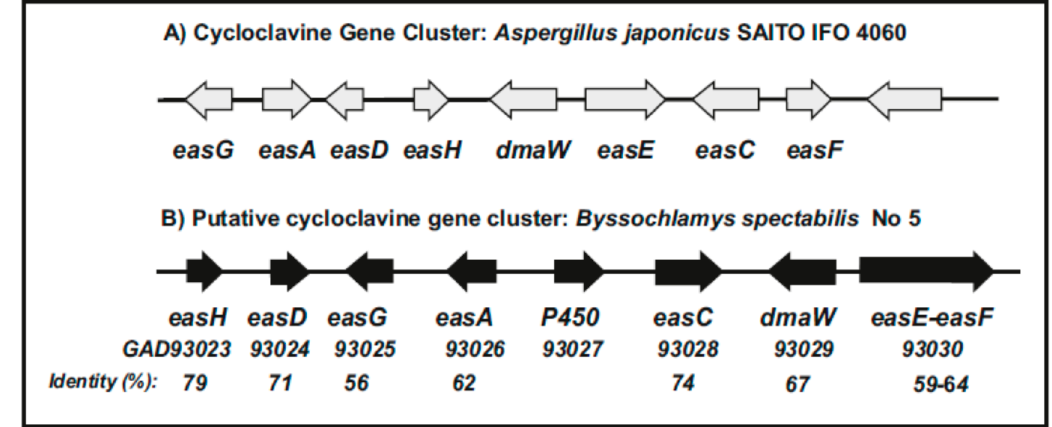
Figure 5. Cluster of homologous genes for clavine biosynthesis in A. japonicus and B. spectabilis. ( A ) Cluster of genes for cycloclavine biosynthesis in A. japonicus ; ( B ) Putative gene cluster for cycloclavine biosynthesis in B. spectabilis . The name of the genes is indicated below the arrows. The accession number of the B. spectabilis genes, as well as the percentage of amino acids identity between the B. spectabilis and the A. japonicus homologous proteins is indicated.